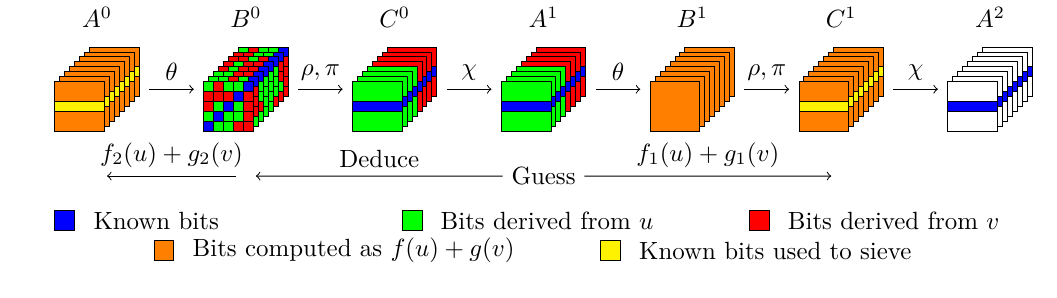
Figure 4: Summary of our basic state-recovery